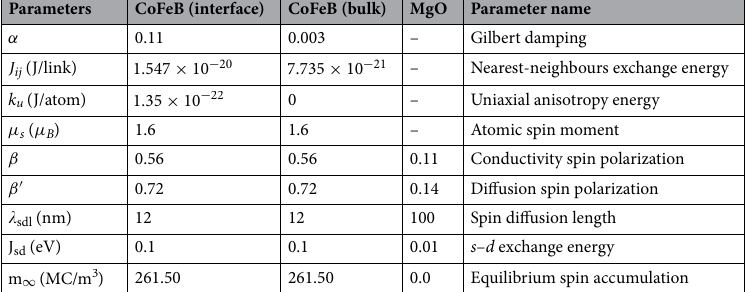
Table 1. Magnetic parameters and transport properties of the CoFeB/MgO/CoFeB system.